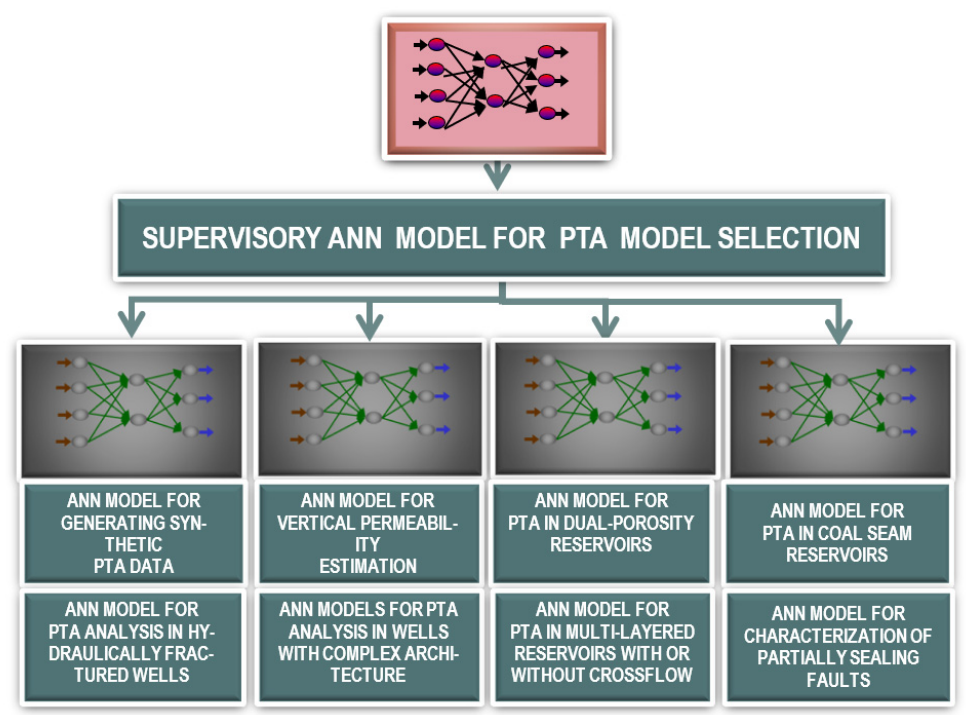
Figure 5. Pressure transient analysis toolbox.